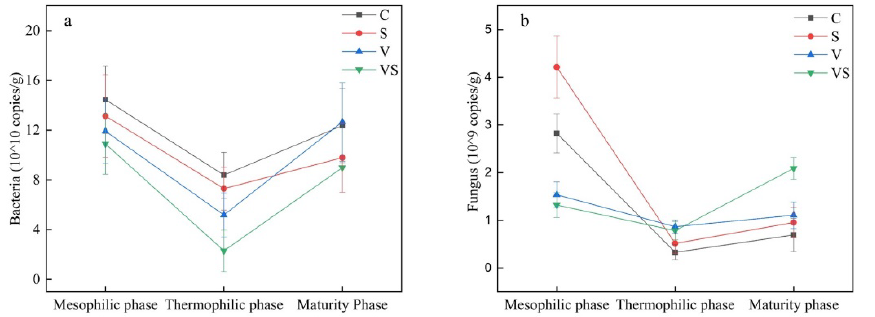
Figure 4. Dynamic changes in biomass (bacteria ( a ) and fungus ( b )) during composting with qPCR analysis of different experiment groups (control (C), ventilation (V), coral sand (S), ventilation and coral sand (VS)).